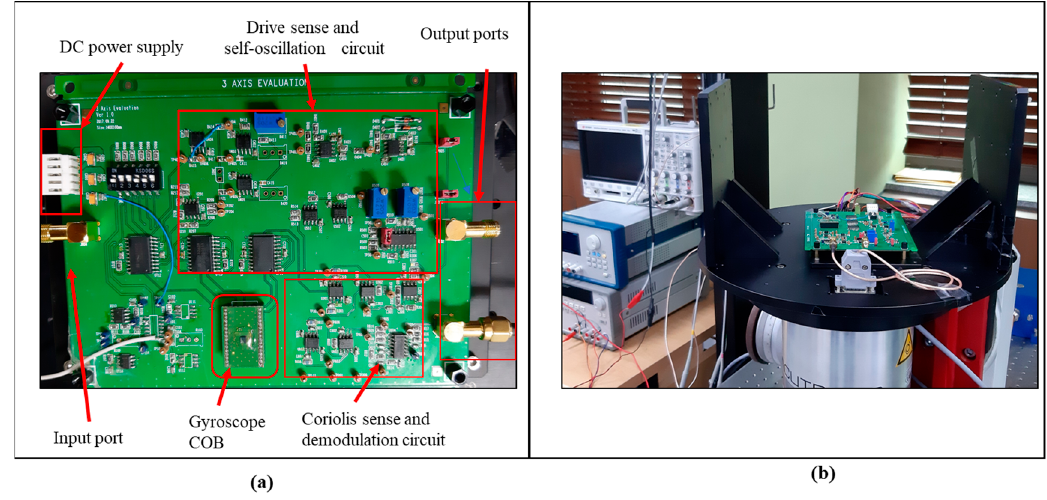
Figure 7. ( a ) Designed PCB for evaluation single drive multi-axis gyroscope. ( b ) Test setup for evaluation of gyroscope.